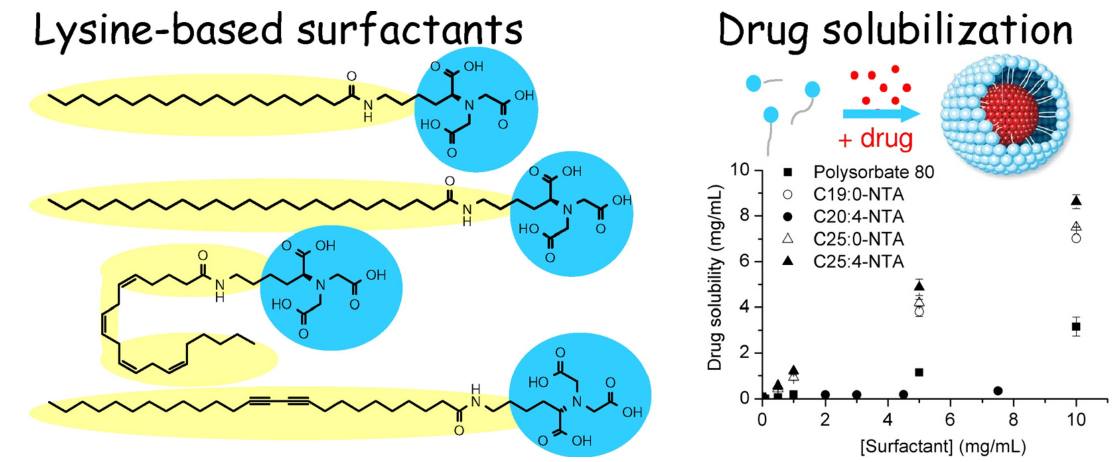
Figure 1. Lysine-based surfactants for the solubilization of anticancer drugs [59]. Copyright 2012 Elsevier. The formulation combining a cationic surfactant based on lysine (N ε -myristoyl lysine methyl ester) and sodium hyaluronic acid was developed for viscose tissue treatment as a wound healing coating [60]. Viscose samples treated in this way showed pronounced antimicrobial property when tested on gram-positive and gram-negative bacteria, and some pathogenic fungi. The authors of [61] managed to obtain nanocontainers based on lysine derivatives for oral use. They were stable in the acidic environment of the stomach and demonstrated prolonged drug release (curcumin) under conditions simulating the small intestine (Figure 2). This dosage form of curcumin reduced the production of inflammatory cytokines and chemokines such as TNFa and CXCL10 more than curcumin solution or suspension.